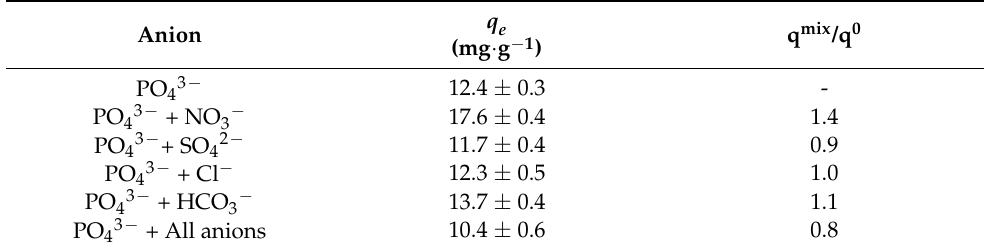
Table 6. Phosphate adsorption capacity onto Mn 2+ /Zn 2+ /Fe 3+ /Mg-Al-LDH composite in presence of competing ions.